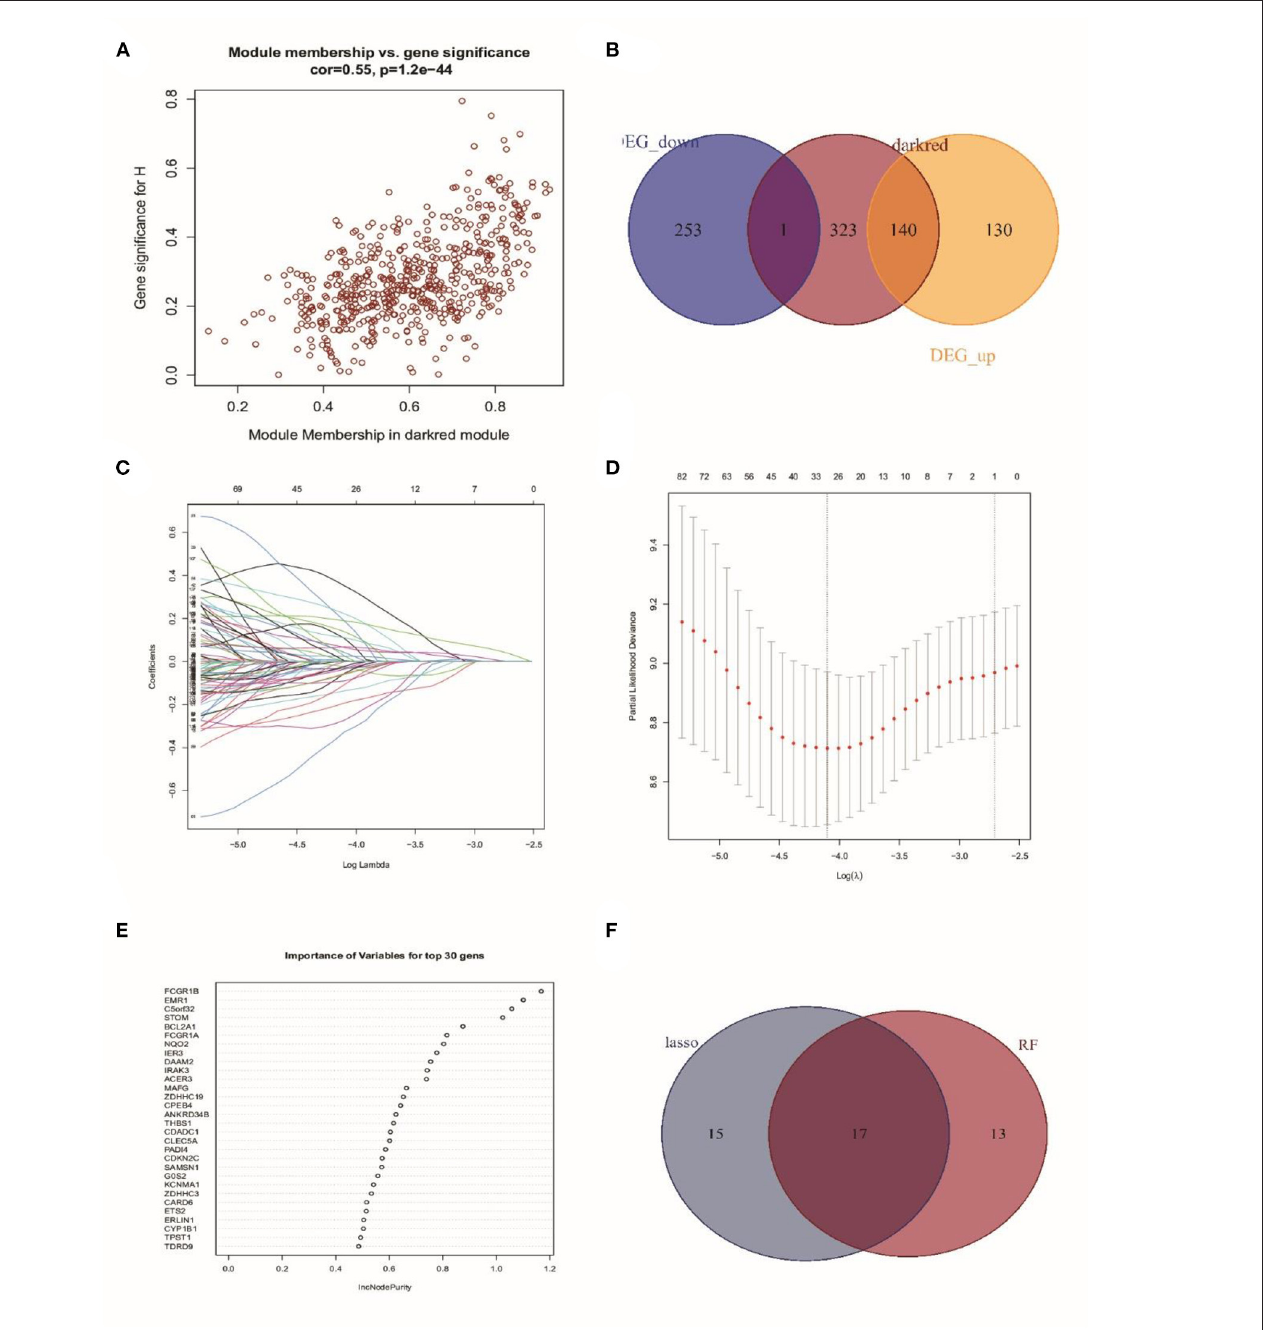
FIGURE 4 | Identification of prognostic genes in patients with sepsis. (A) Extraction of the hub genes of the Darked module. (B) 141 overlapping candidates in the intersection of the DEGs and the Darked module genes. (C,D) LASSO Cox analysis identified 32 prognostic genes. (E) The top 30 prognostic genes in the random forest regression analysis. (F) Venn diagram showed the genes identified by LASSO Cox and random forest regression analyses. A total of 17 prognostic genes were found in the intersection of the results of from LASSO Cox and random forest